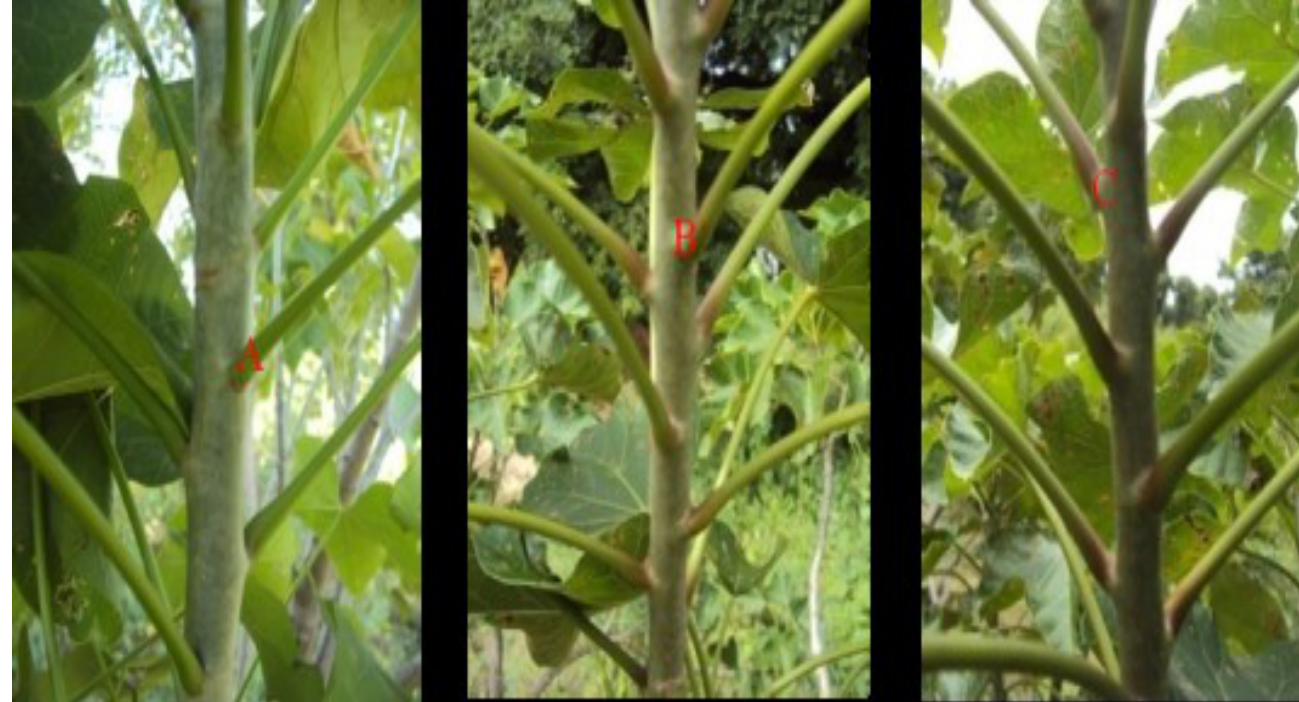
Figure 2. Petiole base pigmentation of J. curcas A : Green (33.33%), B : Brown (13.33%), C : Purple (53.34%)